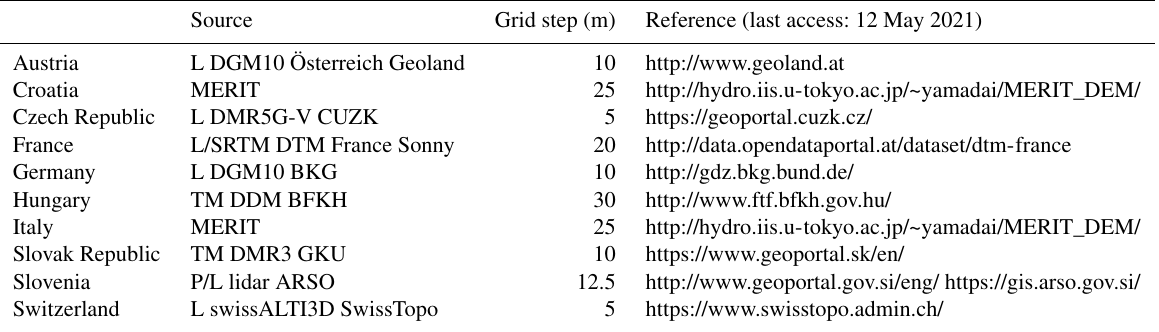
Table C1. List of DEMs used for test and mass correction calculations in the “most inner zone” of the TOPOSK program (Appendix D) of the individual countries; the grid spacing, sources and internet references are given. The letters stand for the techniques used in the DEM compilation: “L” for lidar, “P” for Photogrammetry, “TM” for heights from digitized topographic maps, and “MERIT” and “SRTM” for the radar data.